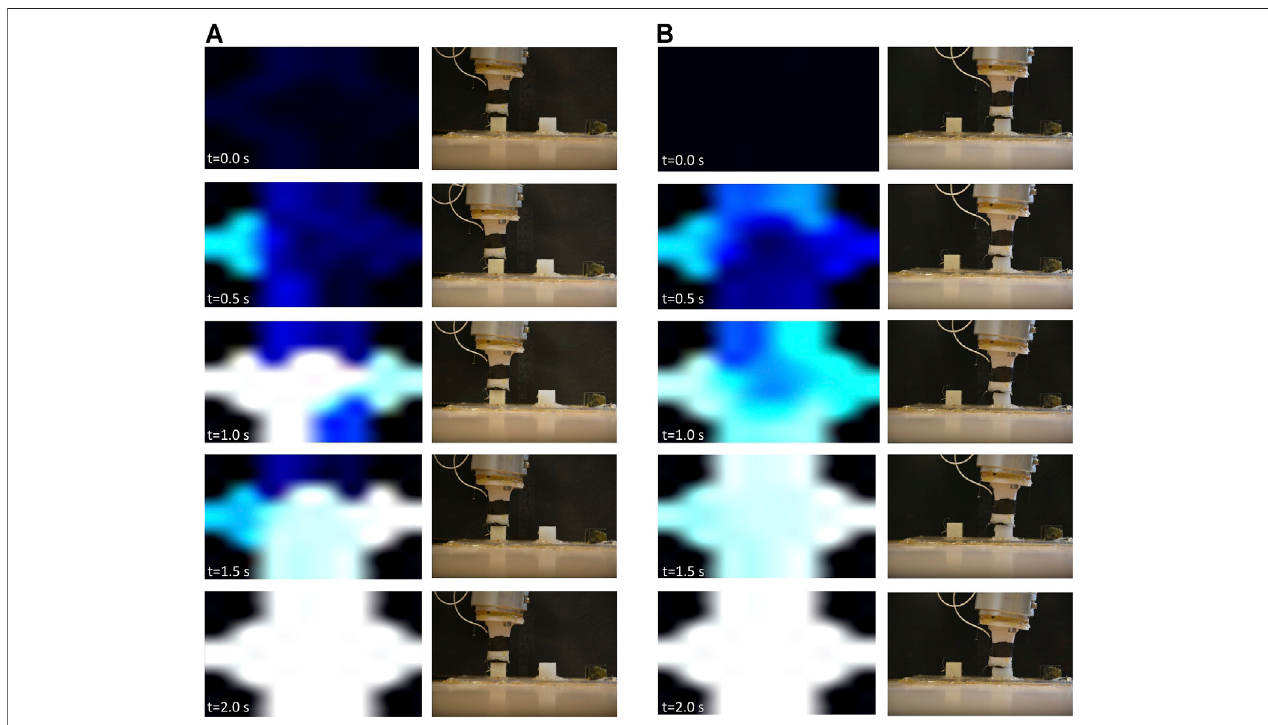
FIGURE 2 | Robot states and corresponding sensor response upon contact with hard (A) and soft (B) dummies. The brighter areas (white) correspond to high recorded pressures by the corresponding taxels, while darker (blue and black) areas correspond to lower pressures. The brightness values are dynamic and change basedon thehistory oftouchedobjectson each trial,wherethey arenormalized basedon thehighestand lowest recordedvalues byeach taxel. Inorder tomaintainthe contact ’ sspatialinformation,thesensordatahavebeen displayed accordingtothehexagonalgeometryofthesensor, whichisover-imposed ontoasquareblack